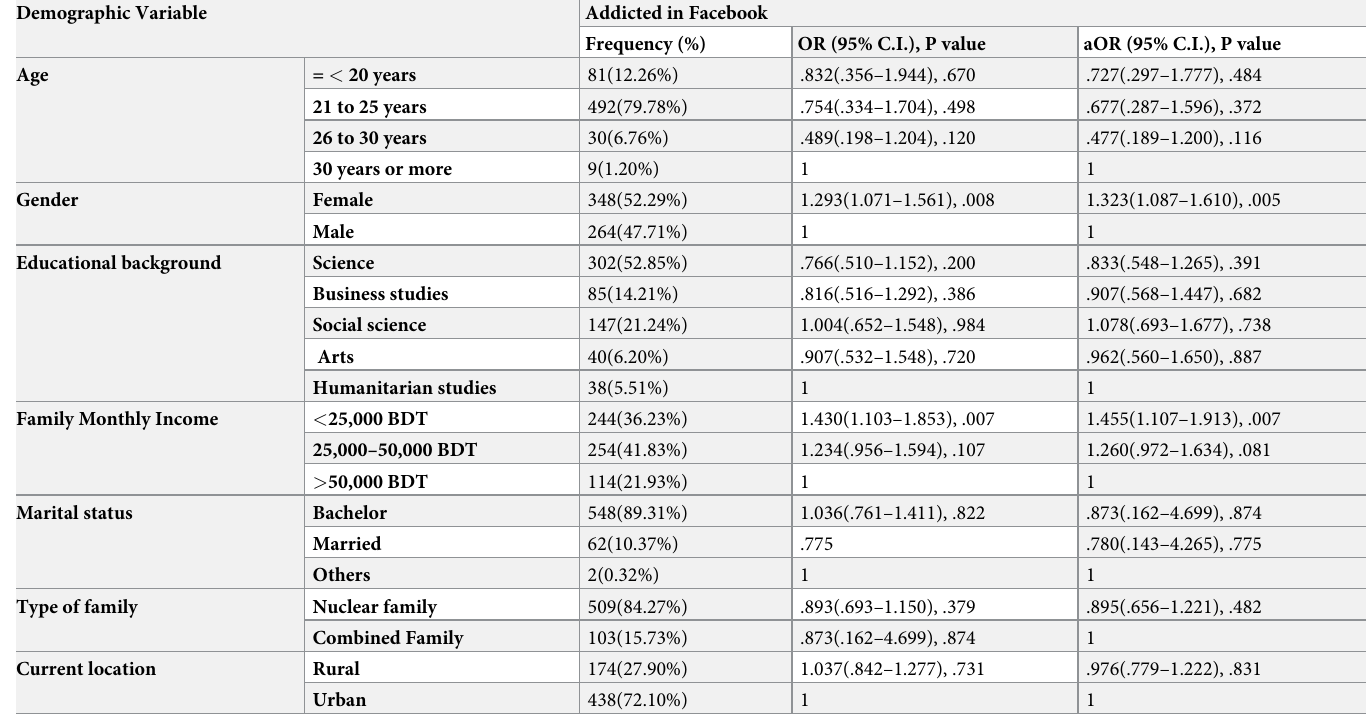
Table 2. Association of the demographic variable and respond with addicted in Facebook.